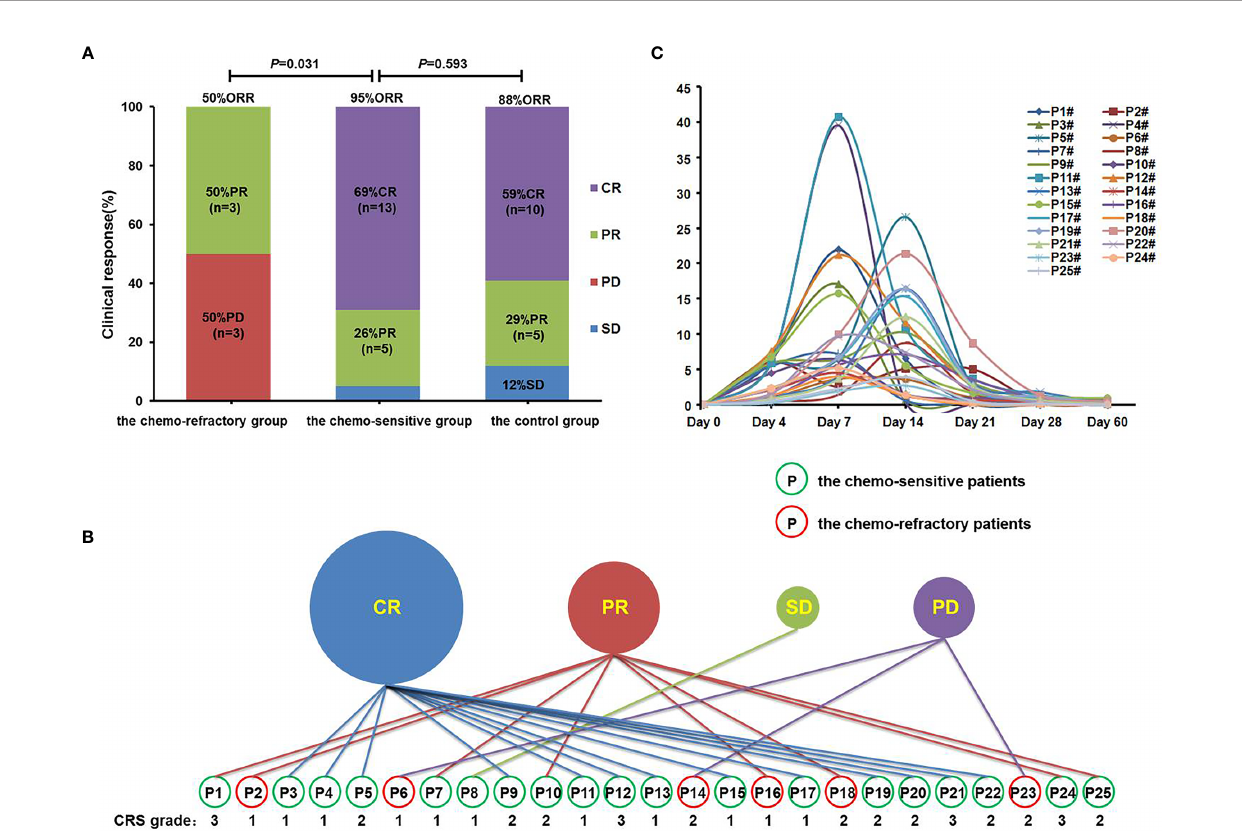
FIGURE 3 | Clinical response, CRS grades, and proportions of anti-CD19-CAR-T cells. (A) Clinical responses were shown in histogram. ORR, objective response rate; CR, complete response; PR, partial response; SD, stable disease; PD, progressive disease. (B) Clinical response and CRS grades of patients in the combined group. Patients in the green circle were sensitive to the debulking chemotherapy, whereas patients in the red circle did not. (C) The proportions of anti-CD19-CAR-T cells of patients in the combined group on days 0, 4, 7, 14, 21, 28, and